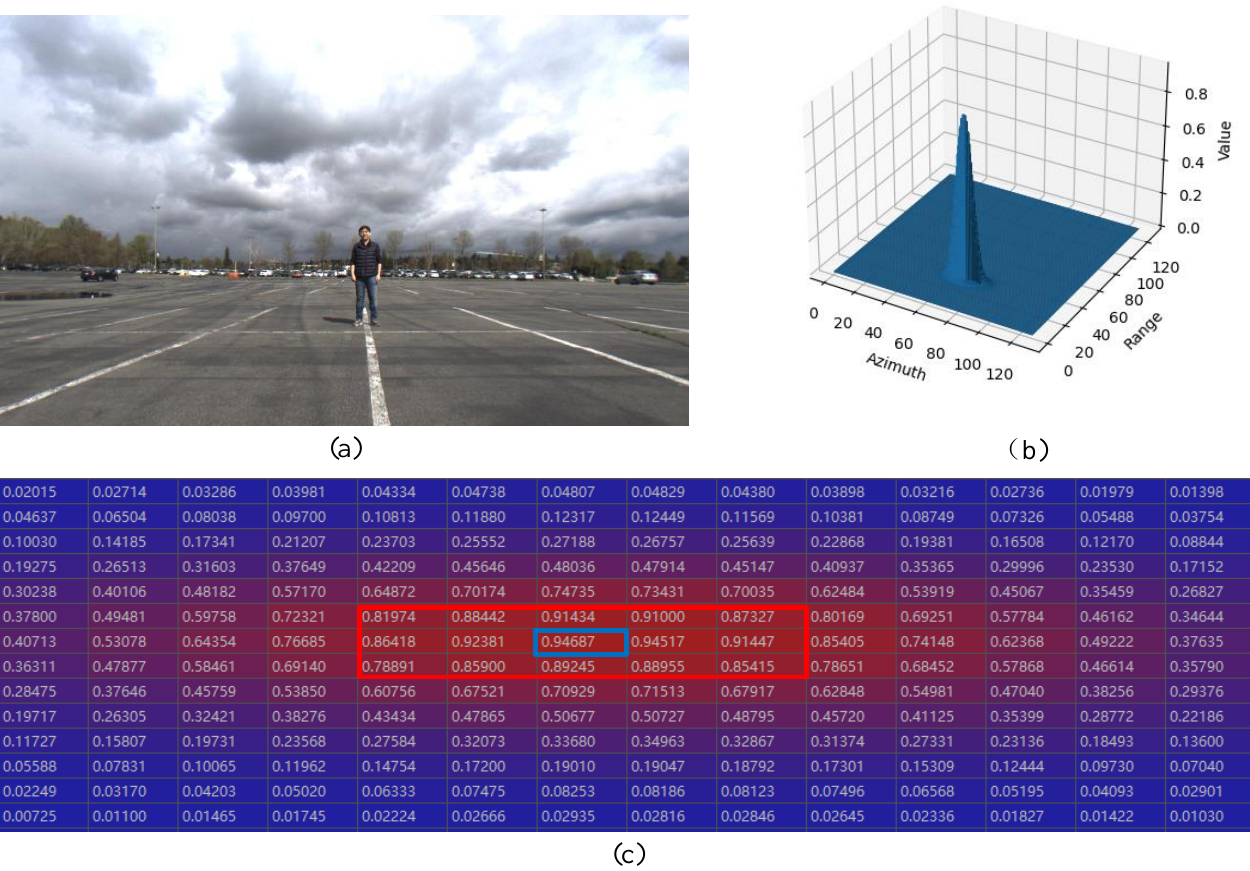
Figure 8. Case (1) data. ( a ) Optical photo of case (1). ( b ) A 2D ConfMap of case (1). ( c ) A 3D ConfMap of case (1). The red box in ( c ) represents a 3 × 5 slider, and the blue box represents the peak that is finally filtered.